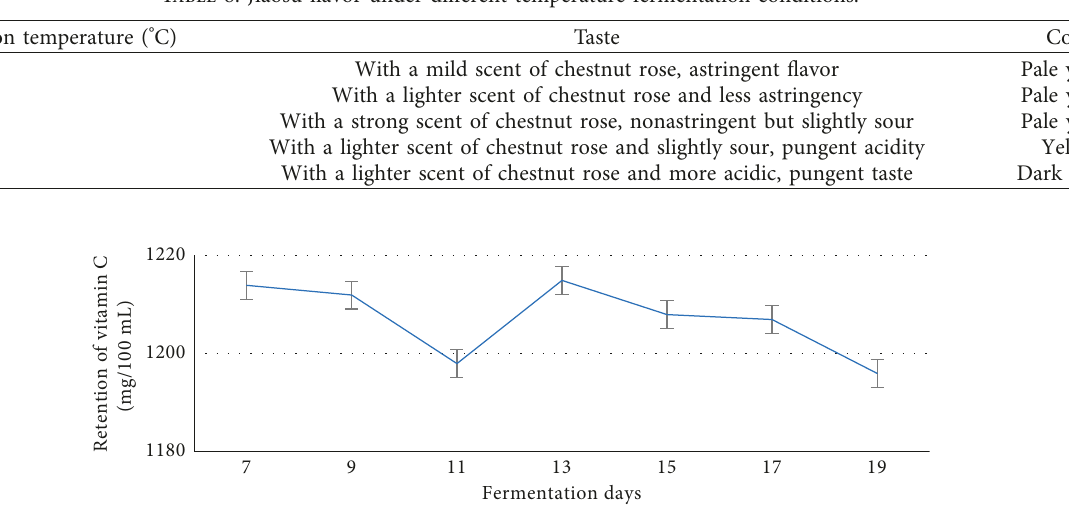
Figure 7: Effect of different fermentation times on the vitamin C content of chestnut rose